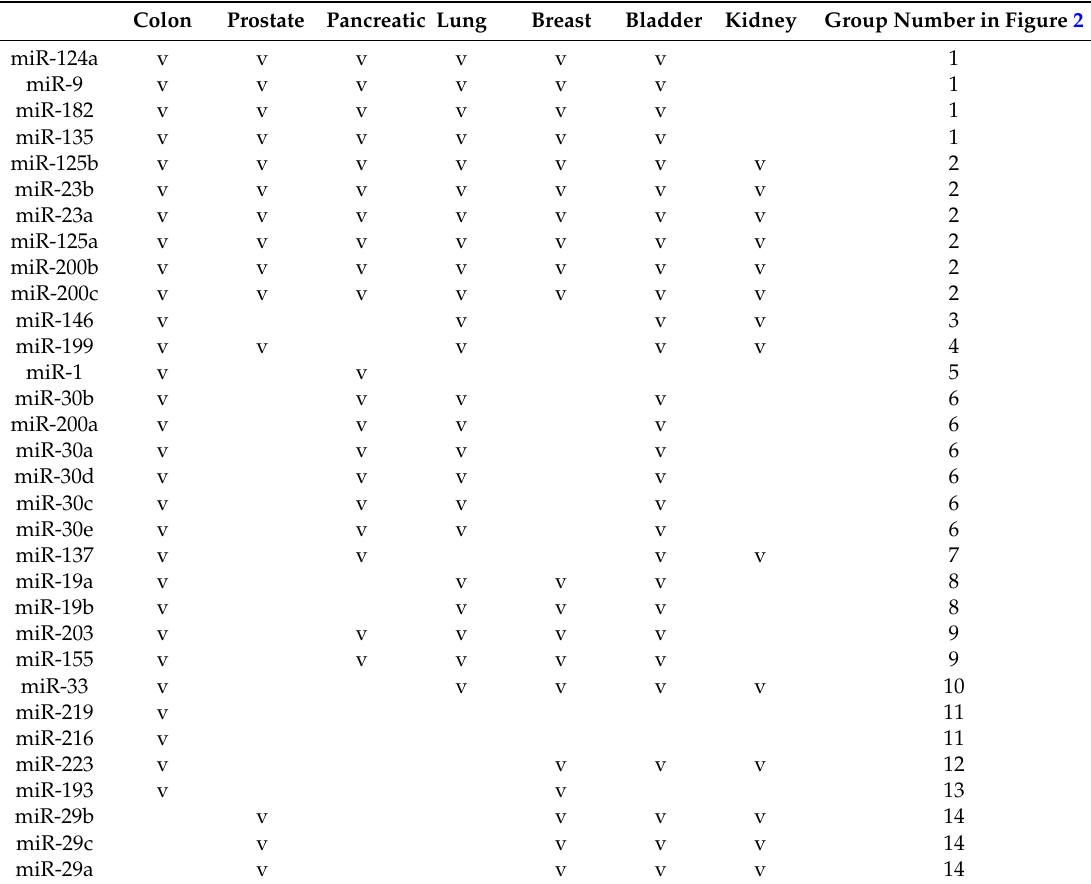
Table 3. Potential cancer-related miRNAs marked by